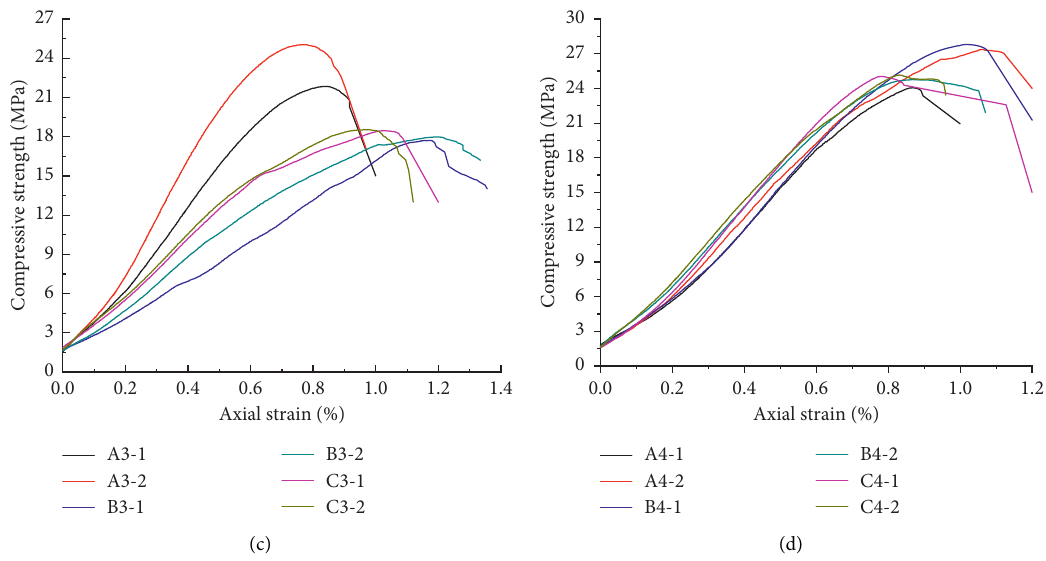
Figure 5: Single-axial compression stress-strain curve of samples. (a) 7-d stress-strain curve. (b) 14-d stress-strain curve. (c) 21-d stress- strain curve. (d) 28-d stress-strain curve. Table 1: Data of colloid cement without uniaxial compressive